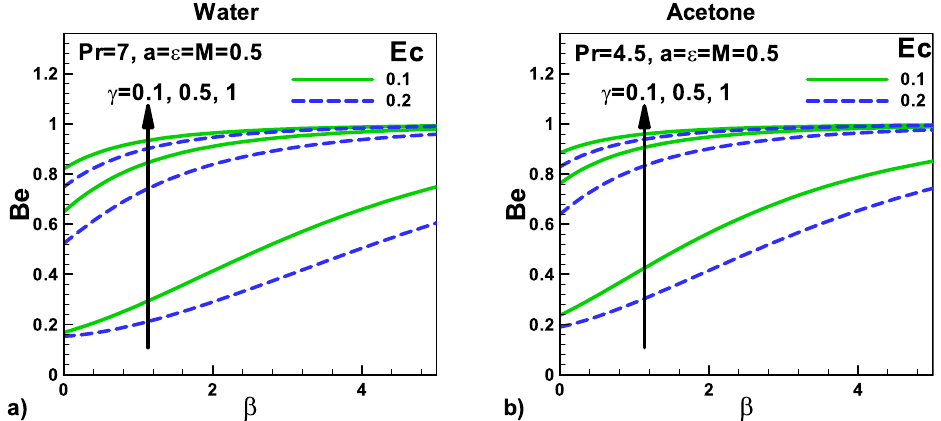
Figure 15. Variation of Bejan number with velocity and thermal slip parameters for ( a ) water ( b ) Acetone.